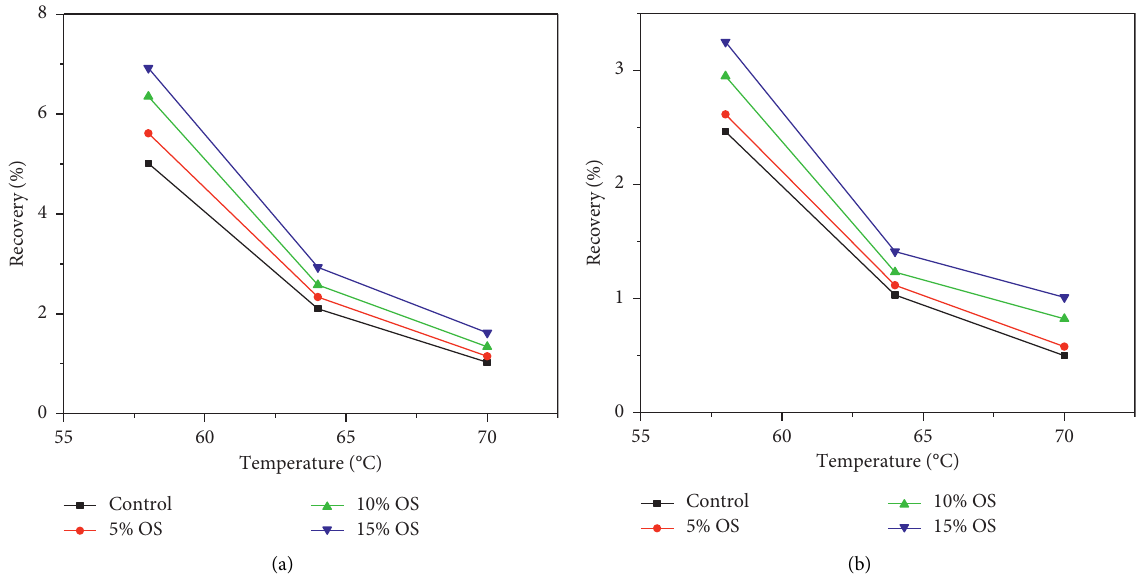
Figure 8: The average recovery rate of the studied materials. (a) 0.1kPa. (b) 3.2